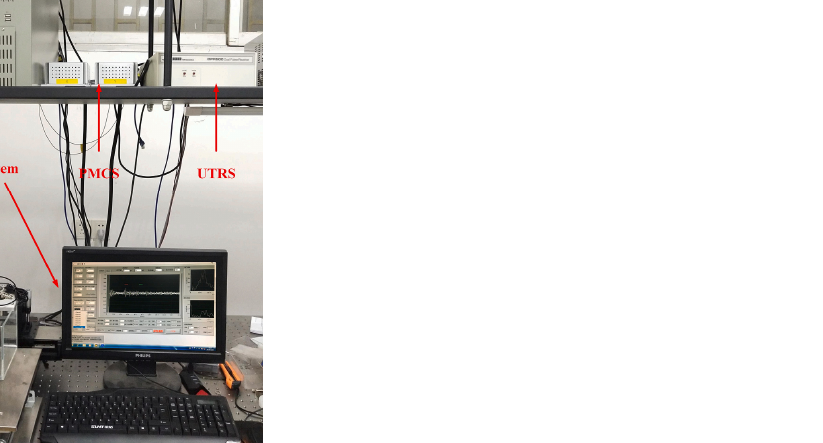
Figure 3. The ultrasonic detection experimental setup for data acquisition.